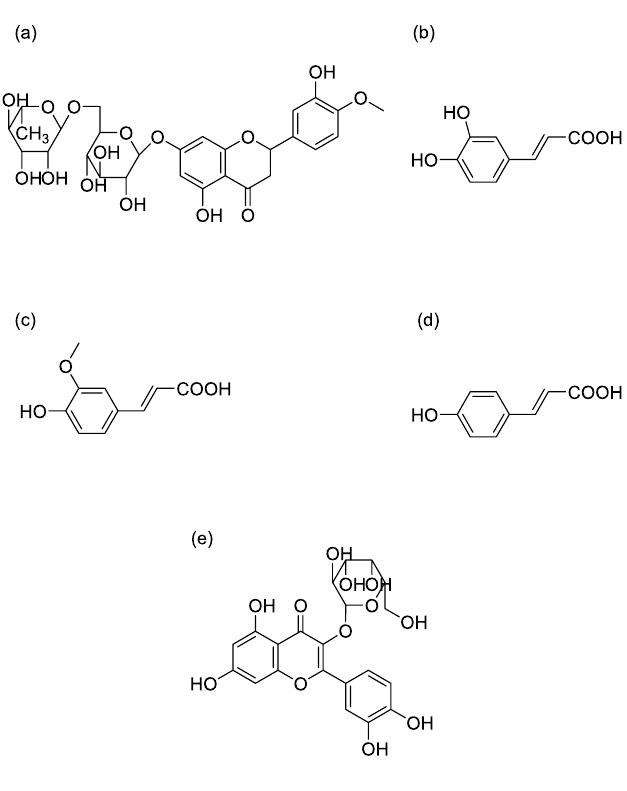
acid, (c) ferulic acid, (d) p -coumaric acid and (e) hyperoside